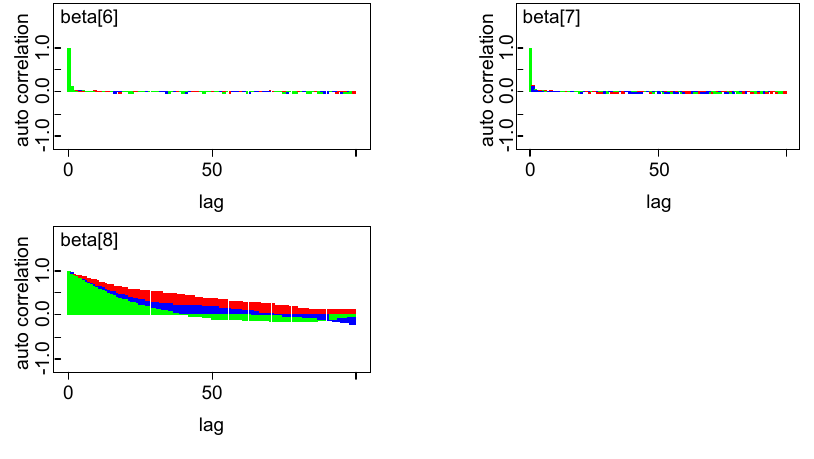
Figure A3. Autocorrelation plot.